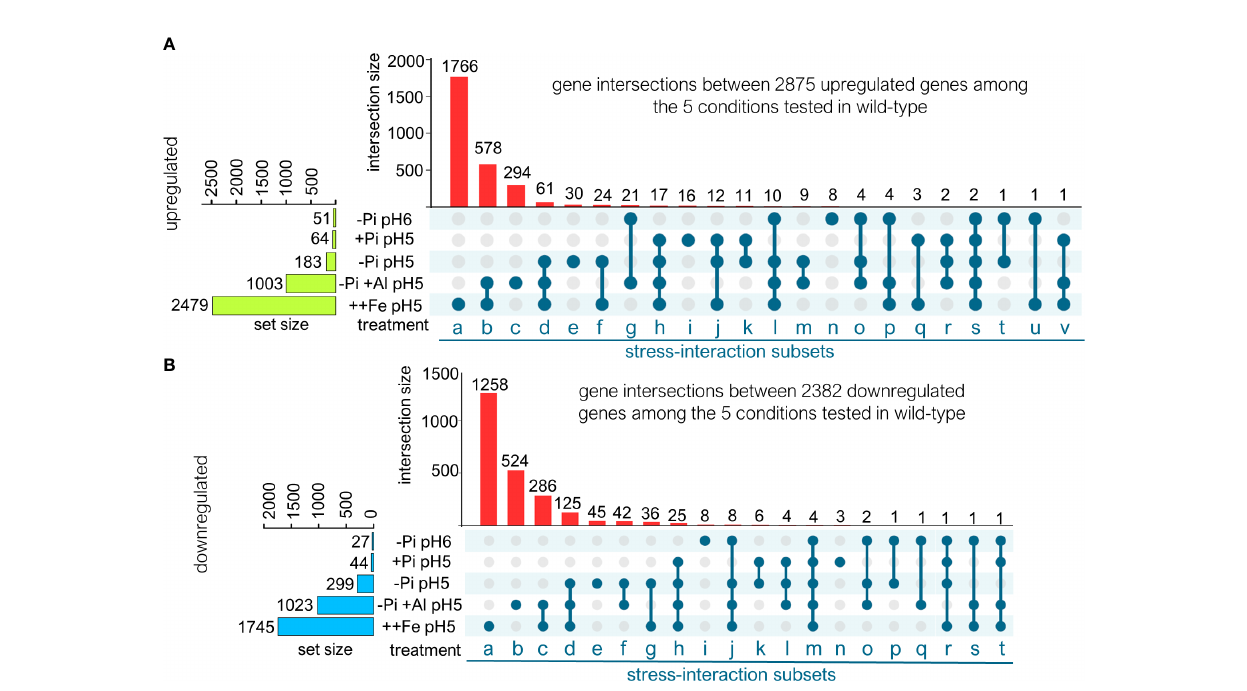
FIGURE 2 | Transcriptomic dissection of upregulated and downregulated gene expression in response to low pH, low Pi, Al and Fe excess. (A) Venn analysis of genes that are differentially upregulated (FDR <.05) under the conditions tested in wild-type (using wild-type pH 6 high-Pi as baseline). Venn diagram is represented in UpSet plot style (see Materials and Methods). Resulting intersection subsets are named using letters. (B) Venn analysis of genes that are differentially downregulated (FDR <.05) under the conditions tested in wild-type (using wild-type pH 6 high-Pi as baseline). Venn diagram is represented in UpSet plot style (see Materials and Methods). Resulting subsets are named using